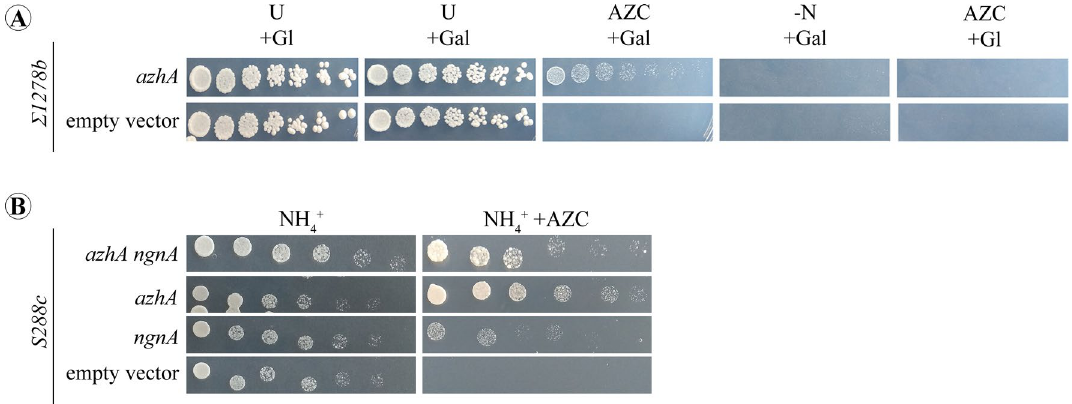
Figure 4. Growth assays of S. cerevisiae strains expressing the A. nidulans azhA and ngnA ORFs. ( A ) Serial dilution assays of Σ1278b strains expressing either the azhA ORF under the regulation of the Gal1 glucose- repressible promoter, or the corresponding empty vector. The Σ1278b strain expressing the azhA ORF ( azhA ) is able to utilize AZC as a nitrogen source only in the presence of galactose (Gal) as a carbon source (AZC/Gal). ( B ) Serial dilution assays of S288C strains expressing either the A. nidulans the azhA and / or the ngnΑ ORFs under the regulation of the Gal1 promoter, or the corresponding empty vector. The S288C strain expressing either the azhA or the ngnΑ ORF is able to detoxify